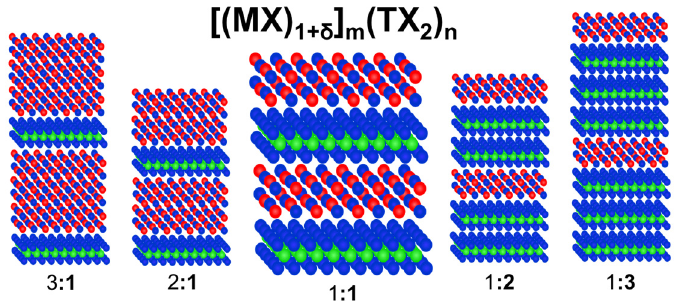
Figure 5. The thermodynamic stability of the reported Misfit Layer Compounds (MLCs) suggests that local free energy minima must exist for other values of m and